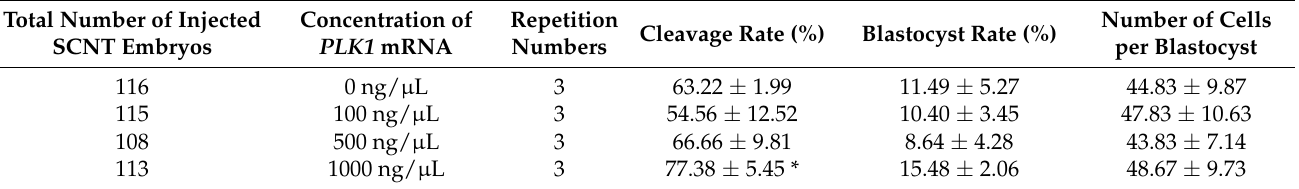
Figure 8. Overexpression of PLK1 in cloned pig embryos. ( A ) PLK1 protein abundance in the NT-211 and NT-22b groups, as measured by microproteomics. “**” represent a significant difference at p < 0.01. ( B ) PLK1 mRNA levels in the NC and PDCD6i groups, as measured by transcriptomics. ( C ) PLK1 expression plasmid map. ( D ) PLK1 mRNA produced via in vitro transcription. 1 (cid:13) and 2 (cid:13) denotes the electrophoresis analysis of PLK1 mRNA after 3 (cid:48) -capping and 5 (cid:48) -tailing, respectively. Table 4. The effects of PLK1 mRNA microinjection on the in vitro developmental efficiency of SCNT pig